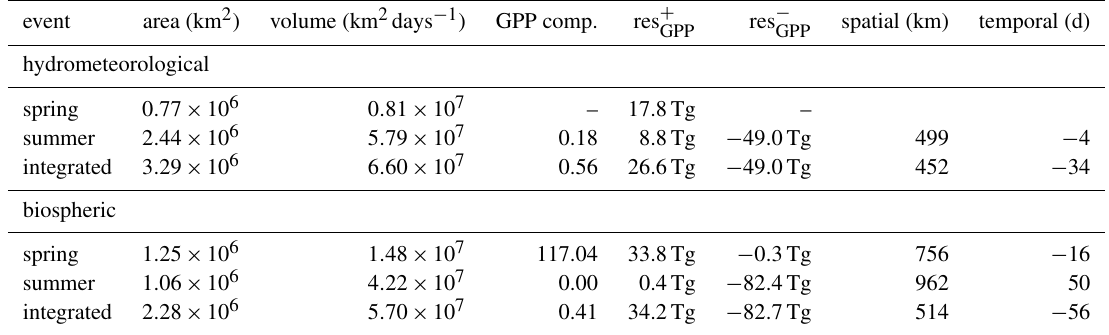
Table 1. Statistics of the extreme events, based on their spatiotemporal connectivity structure: affected area, affected volume, positive and negative GPP response (res + / − ) to the event, compensation of the negative response (comp.), as well as average spatial and temporal distance between the parts of the events with positive and negative